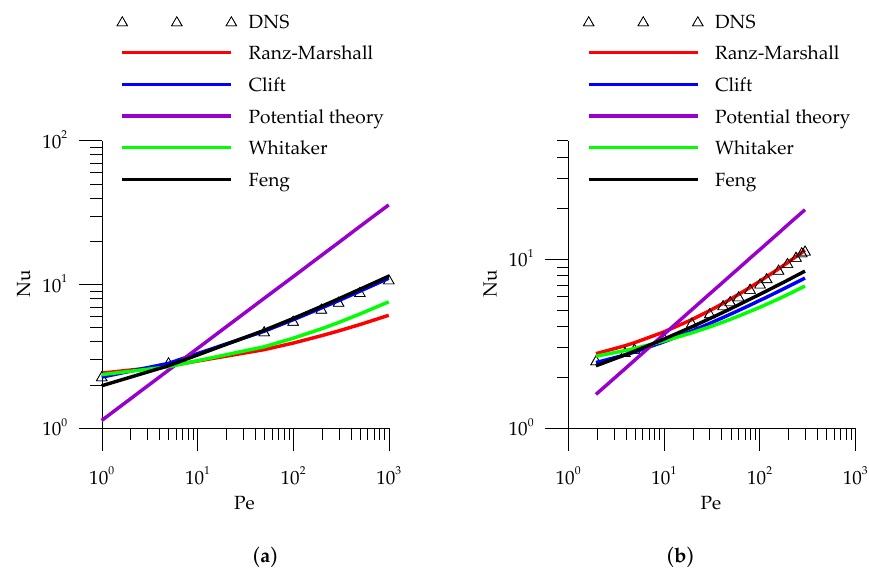
Figure 5. Applicability of correlations for predicting the average Nusselt number of fully contaminated spherical bubbles (DNS data from [63]): ( a ) Re p = 0.1, Pr l = 1 ∼ 10 4 . ( b ) Re p = 1 ∼ 150, Pr l = 2. DNS: Direct Numerical